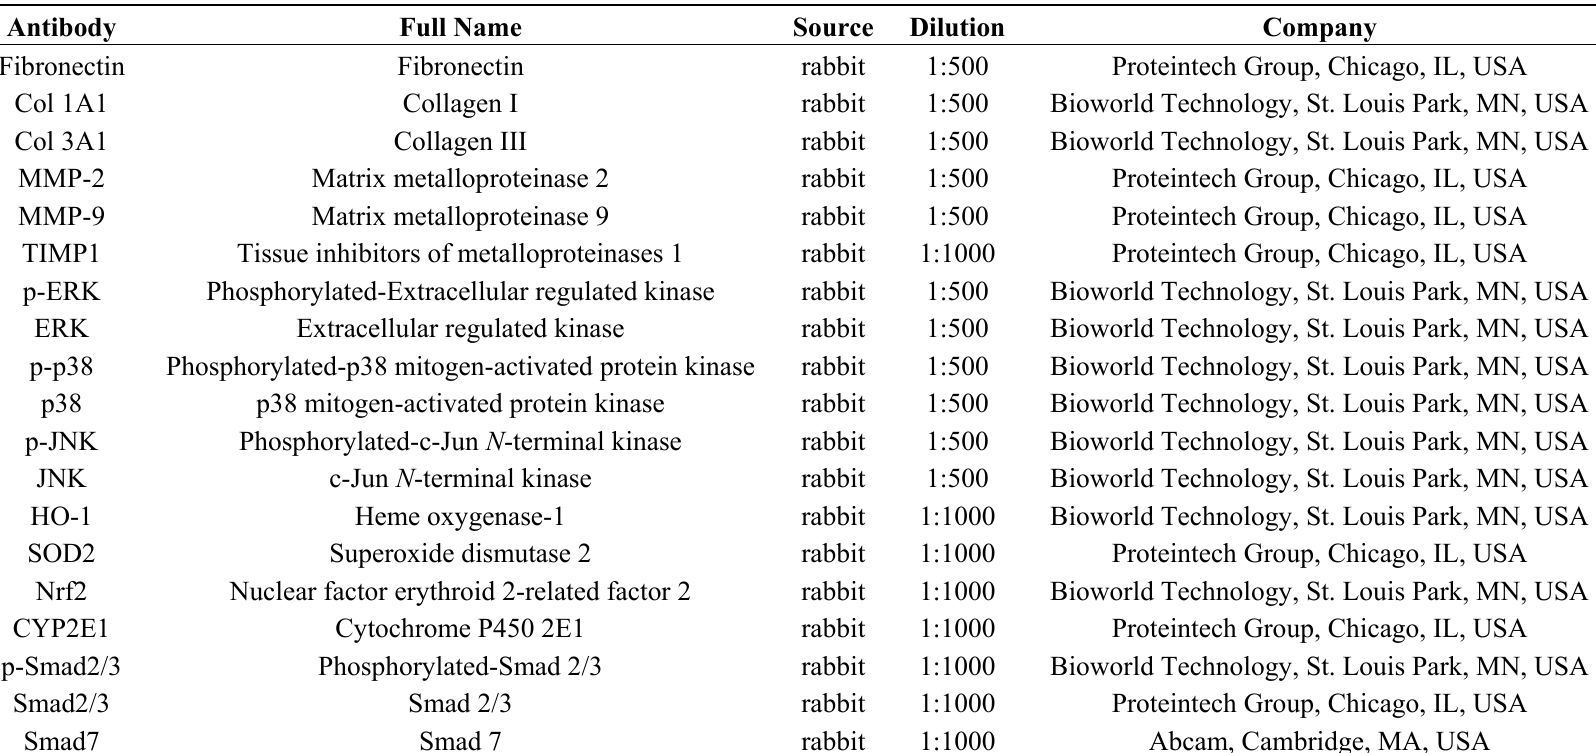
Table 2. The information of the antibodies used in the present